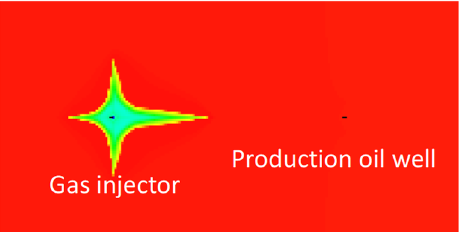
Figure 4. Distribution of formation oil saturation at 30 days of production.